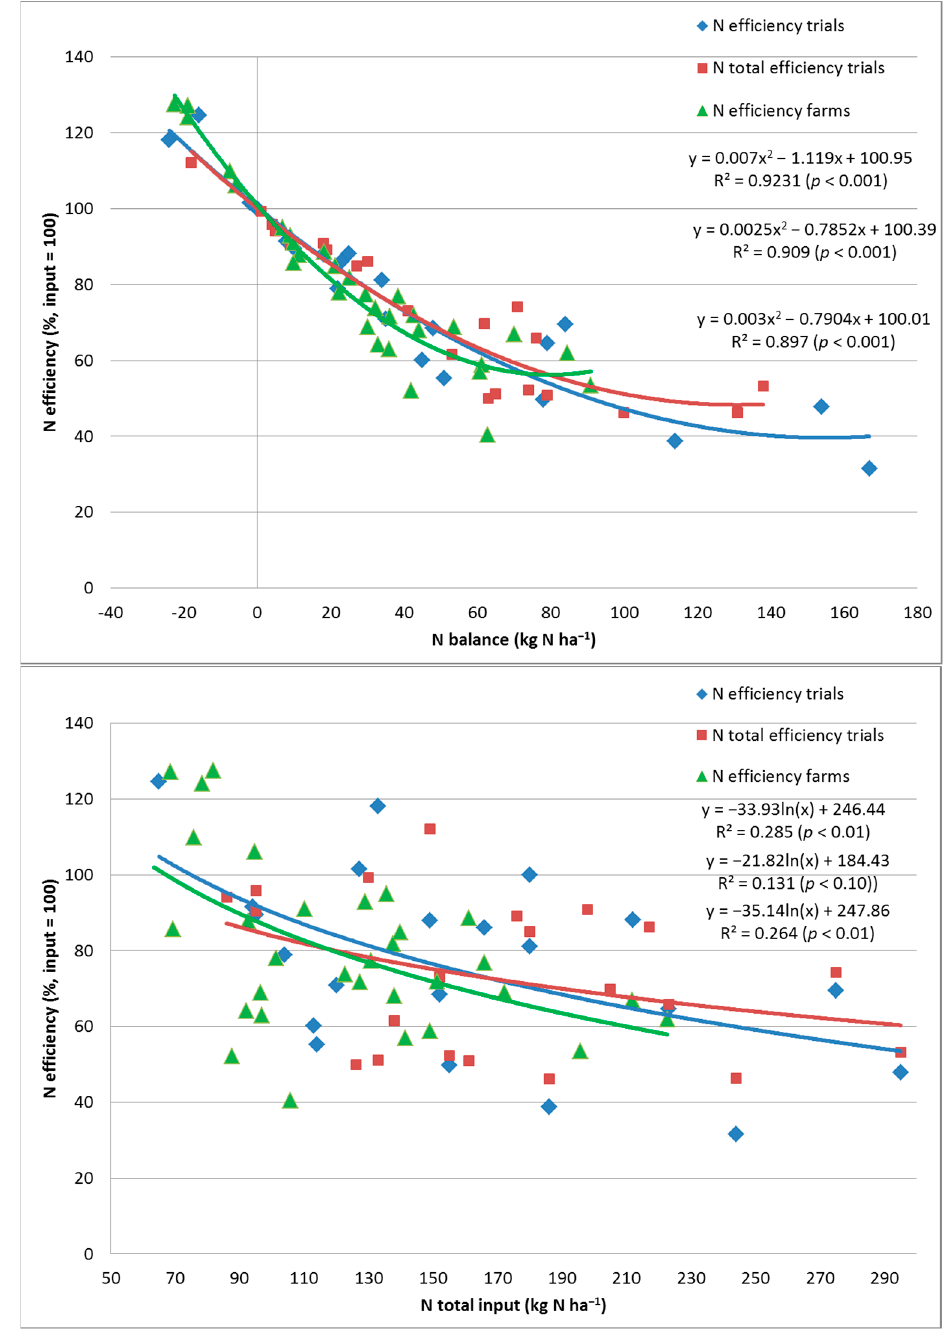
Figure 11. Relationship between N balances ( above ) or N supply ( below ) and the determined N efficiencies in the trial studies presented here on heavy soils and in organic farming